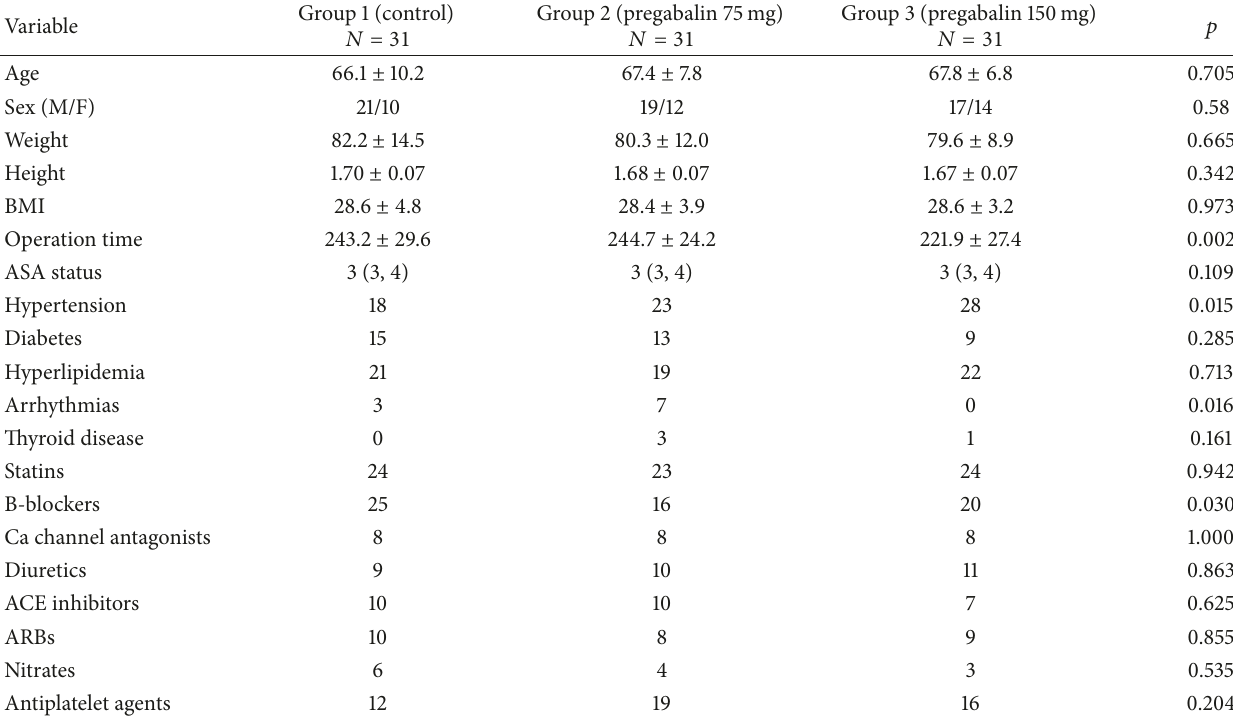
Table 1: Demographic and clinical patient characteristics. Data reported as mean ± SD, median (range), or number of patients, as appropriate. Values were compared between groups using ANOVA, Kruskal-Wallis, or Chi-square tests as appropriate. 𝑝 values for significance were adjusted to 0.05/20 = 0.0025 using Bonferroni correction for multiple